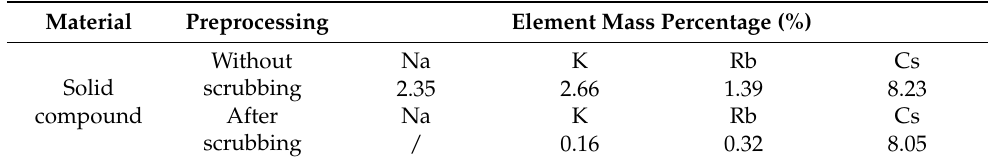
Figure 7. XRD patterns of the solid compound dried at 120 °C. Table 2. Chemical composition of the solid compound.